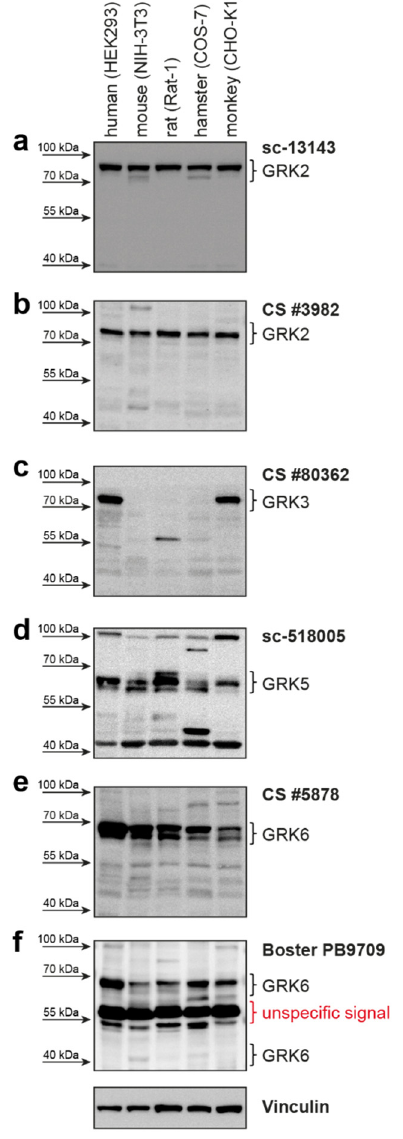
Figure 2. Species reactivity of tested antibodies. ( a – f ) Western blot analysis of HEK293 (human), NIH-3T3 (mouse), COS-7 (hamster), Rat-1 (rat), and CHO-K1 (monkey) cell lysates using the denoted anti-GRK antibodies. Vinculin served as loading control.